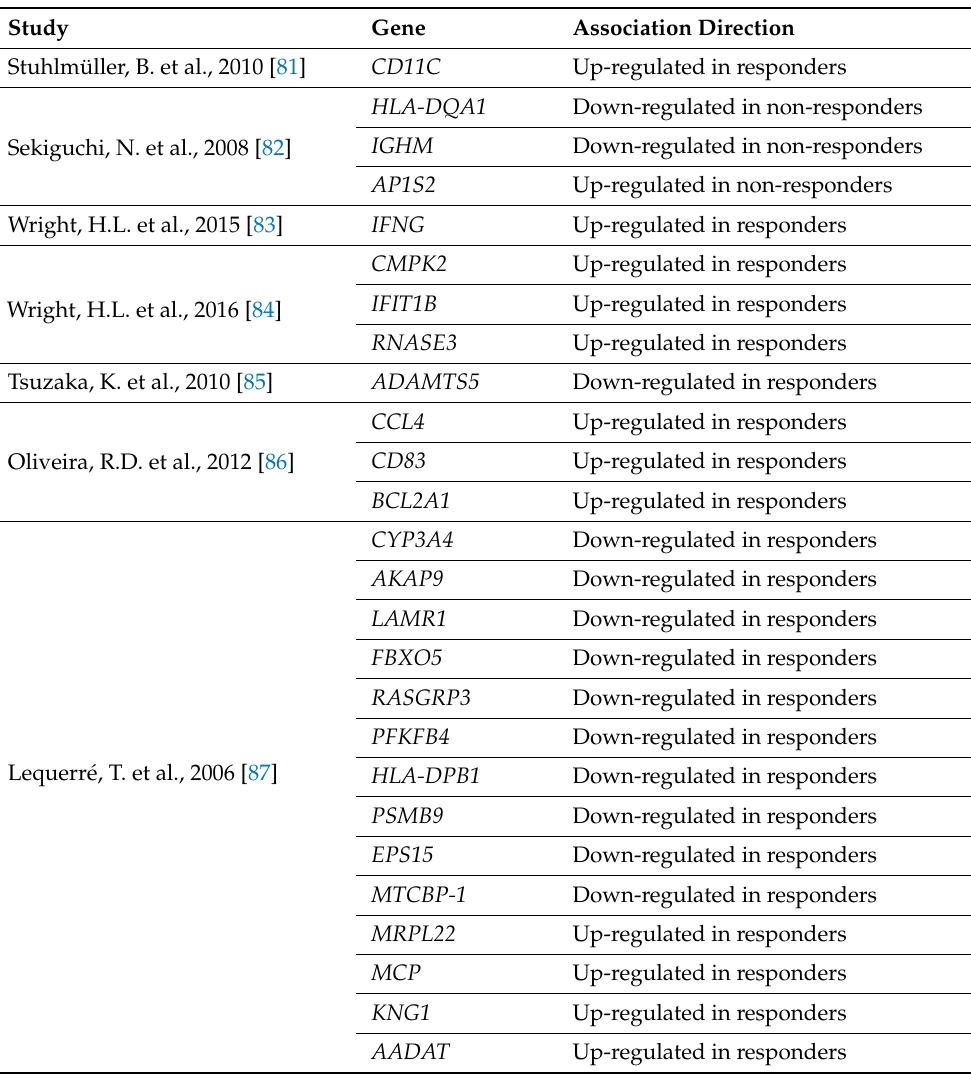
Table 3. RNA biomarkers of response to anti-TNF therapy in